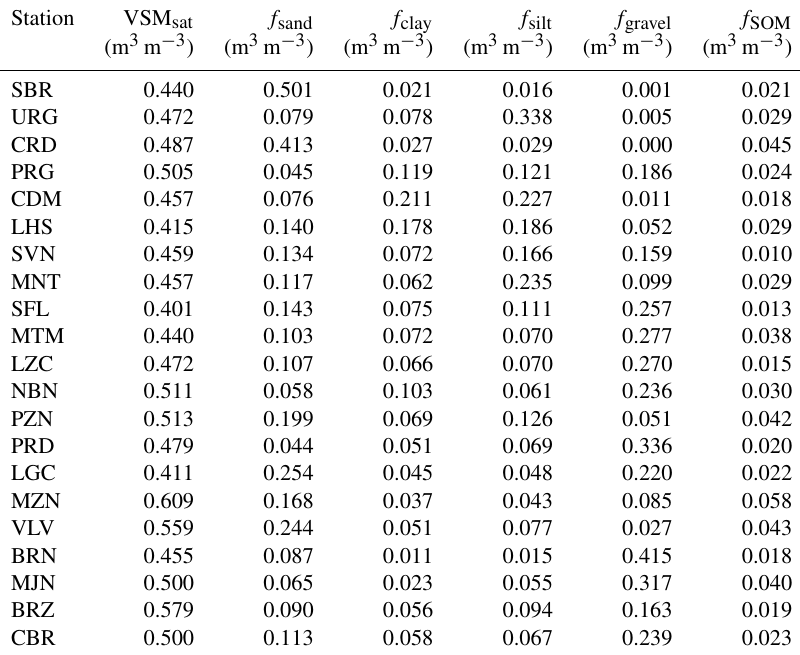
Table 3. Soil characteristics at a depth of 5cm for the 21 stations of the SMOSMANIA network. The volumetric fractions of sand, clay, and silt at 5cm ( f sand , f clay , and f silt ) are measured, and the volumetric fractions of gravel and soil organic matter (SOM) ( f gravel and f SOM ) at 5cm are derived from measurements at 10cm. VSM sat is the porosity representing VSM at saturation (VSM sat = 1 − f sand − f clay − f silt − f gravel − f SOM ). Stations are listed from (top) west to (bottom)